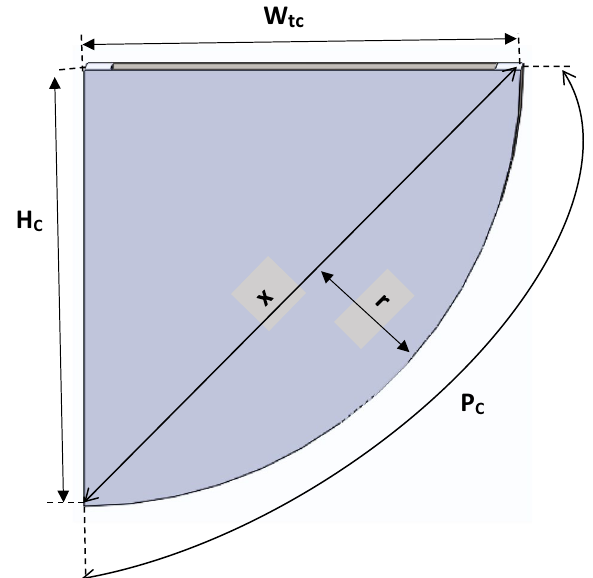
Figure 8. Section of the elevator cup